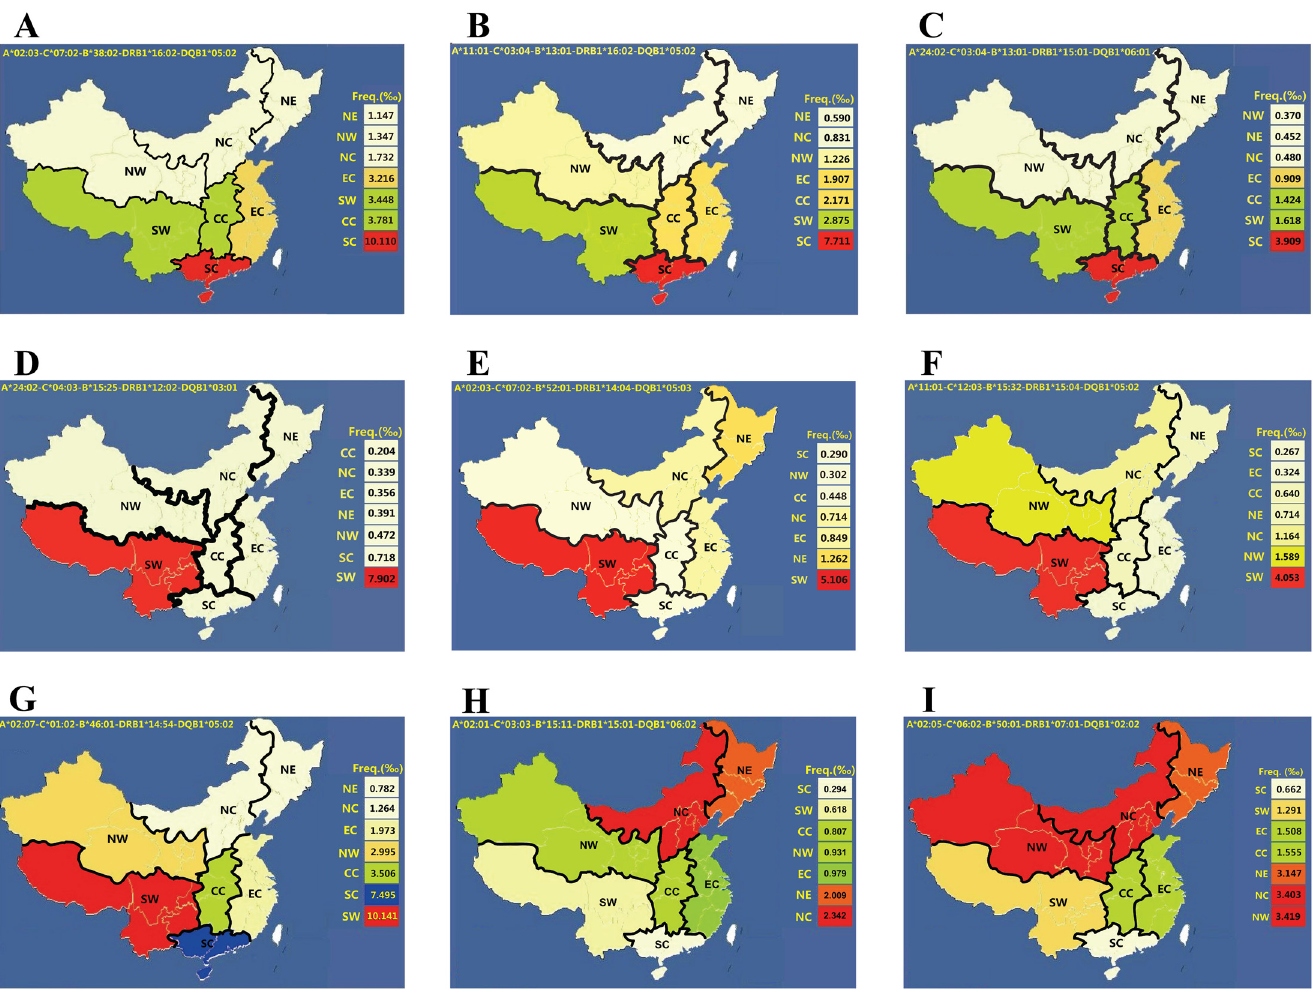
Fig 4. Different distributions of region-specific HLA five-locus haplotypes in the seven geographic regions of China. A: A * 02:03-C * 07:02-B * 38:02-DRB1 * 16:02-DQB1 * 05:02 haplotype (the 20 th haplotype); B: A * 11:01-C * 03:04-B * 13:01-DRB1 * 16:02-DQB1 * 05:02